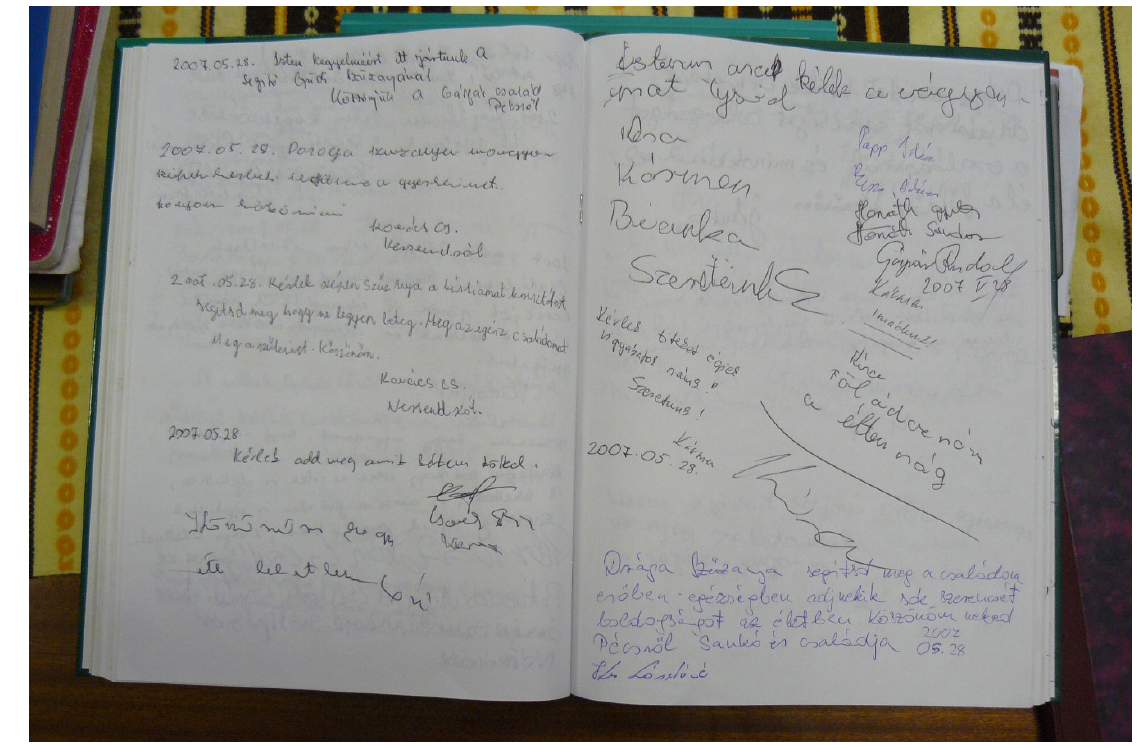
Figure 7. A Guestbook from the archive of Máriagy ű d, Photo taken by Krisztina Frauhammer, 2008.